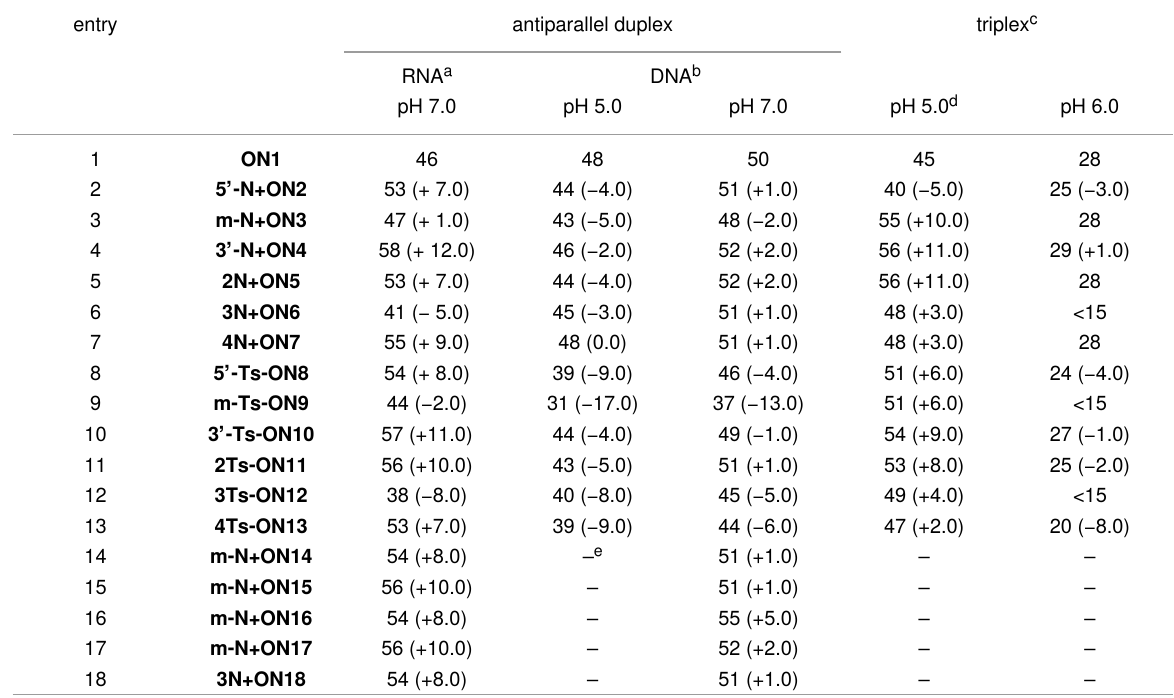
Table 2: T m [°C, ± 0.5 °C] data for triplex and duplex melting, taken from UV melting curves ( λ = 260 nm). entry